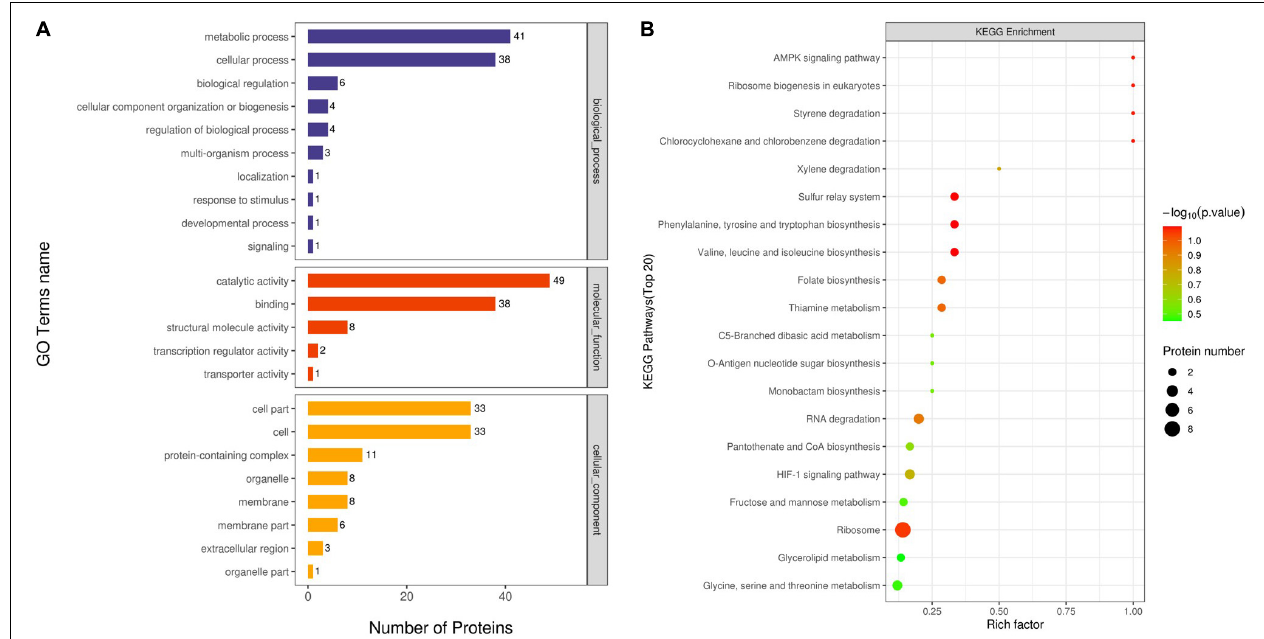
FIGURE 5 | Gene ontology (GO) analysis of all DEPs (A) . Proteins were classified according to biological process, cellular component, and molecular function. The top terms of the KEGG pathway for DEPs for OEO treatment-vs.-control (B) .